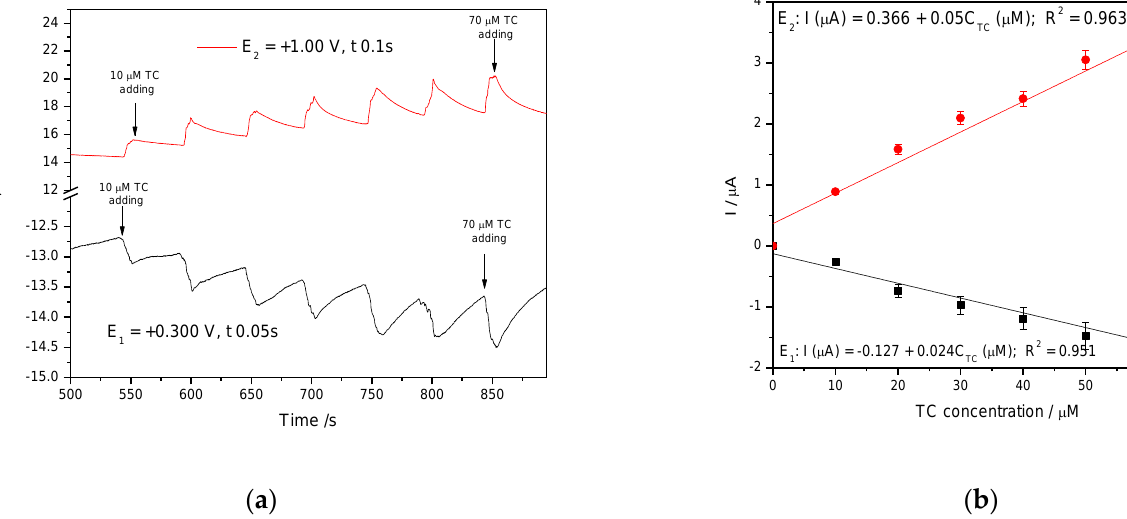
Figure 14. ( a ) MPAs recorded at Ag/GO/BDD electrode in 0.1 M NaOH supporting electrolyte, in the presence of 10-70 µM TC concentration: 10 µM, 20 µM, 30 µM, 40 µM, 50 µM, 60 µM, 70 µM at two applied potential levels, i.e. +0.300 V/SCE and +1.00 V/SCE. ( b ) Calibration plots for tetracycline detection in the concentration range 10-70 µM recorded at the potential E 1 = +0.300 V/SCE and E 2 = +1.00 V/SCE.